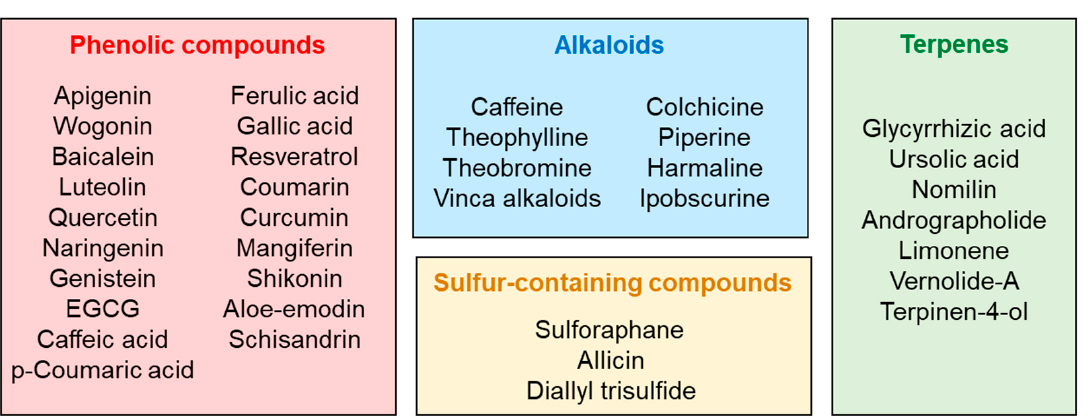
Figure 5. Main secondary metabolites with immunomodulatory activity on melanoma addressed in this